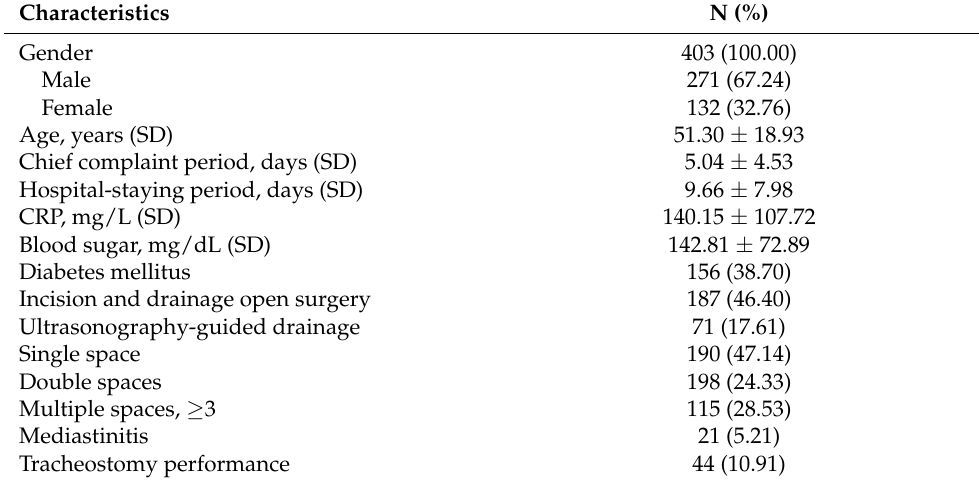
Table 1. Clinicopathological characteristics of the 403 patients with deep neck infection.